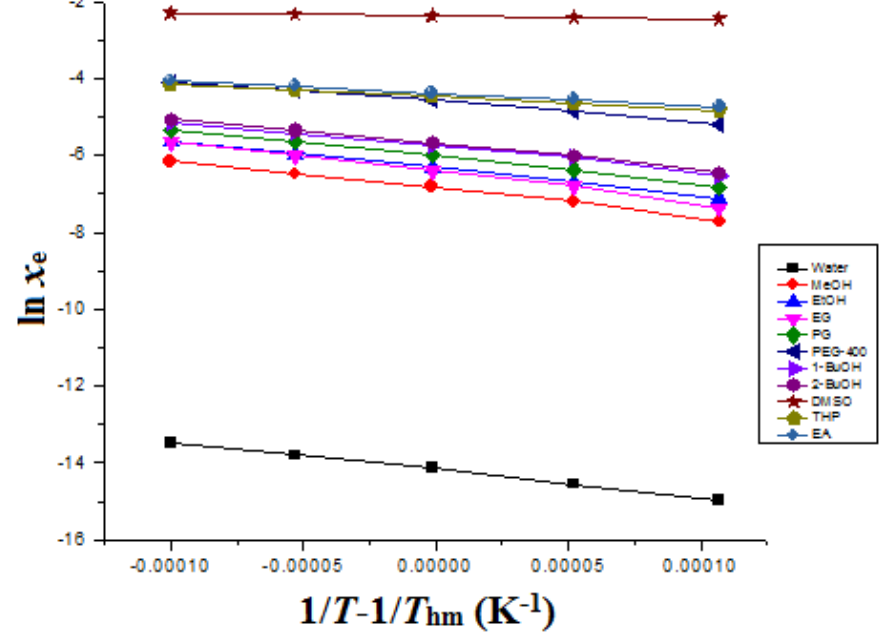
Figure 2. van’t Hoff curves for ITN in eleven distinct green solvents.